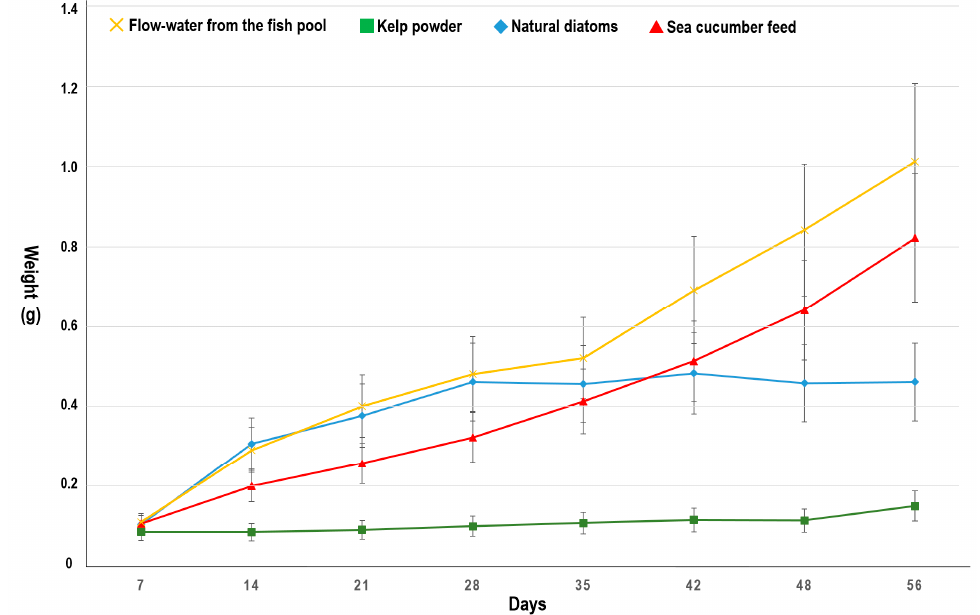
Figure 4. Laevistrombus canarium . Mean ( ± sd) weight of 10 mm juveniles at various sampling during 56 days of feeding on four diets (flow water, natural diatoms, sea cucumber feed, kelp powder). Table 2. Laevistrombus canarium . Mean (± sd) values of weight, shell length, shell width, shell depth, survival rate, and daily growth rate of 10-mm juveniles after 56 days of feeding on four diets (flow water, natural diatoms, sea cucumber feed, kelp powder).